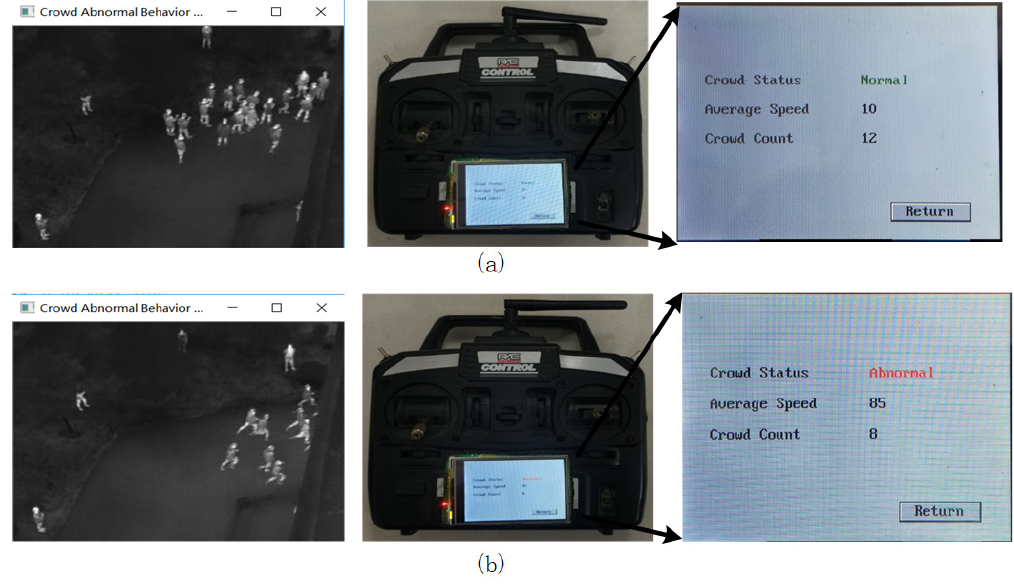
Figure 12. Crowd-status information of the scene close to the building. ( a ) Normal; ( b ) abnormal.